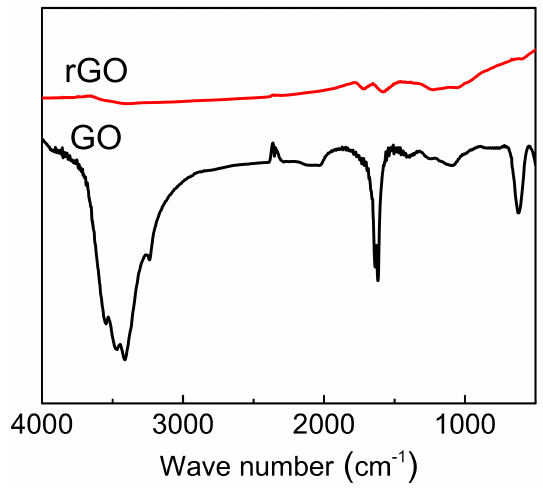
Figure 5. FTIR spectra of graphene oxide (GO) and reduced graphene oxide